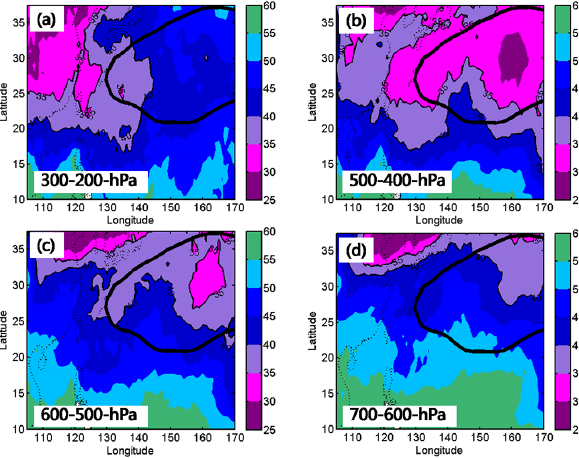
Figure 2. September 2004–2009 mean AIRS–AMSU-derived RHs (shading) in (a) 300–200hPa, (b) 500–400hPa, (c) 600–500hPa, and (d) 700–600hPa layers, respectively. Black contours are drawn at 40 and 35% RH in each panel. The thick black line is the mean GFS-derived geopotential height of 5880m at